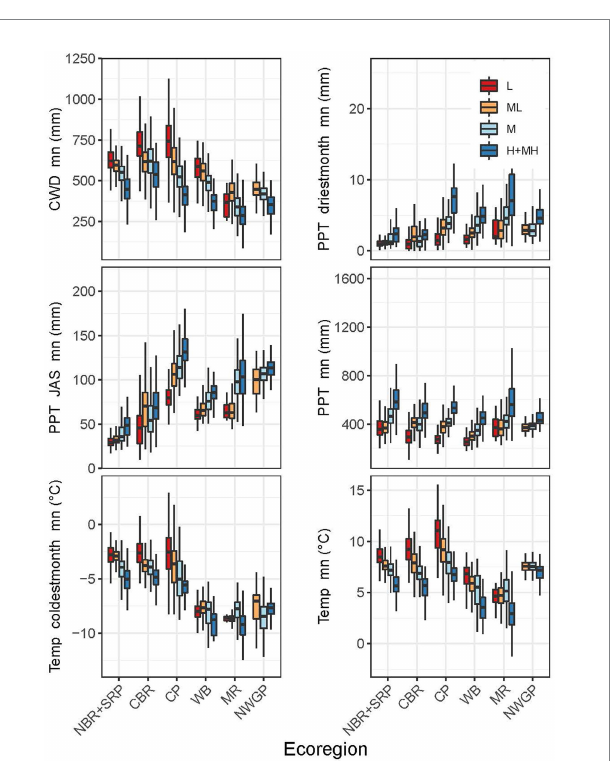
FIGURE 9 Boxplots for the most highly ranked predictor variables of resilience for each ecoregion by resilience category. Boxplot show the median at the box’s center, the first and third quartiles (25th and 75th percentiles) as the box’s hinges, and whiskers extending to the largest and smallest values. NBR, Northern Basin and Range; SRP, Snake River Plain; CBR, Central Basin and Range; CP, Colorado Plateau; WB, Wyoming Basin; MR, Middle Rockies; NWGP, Northwestern Great